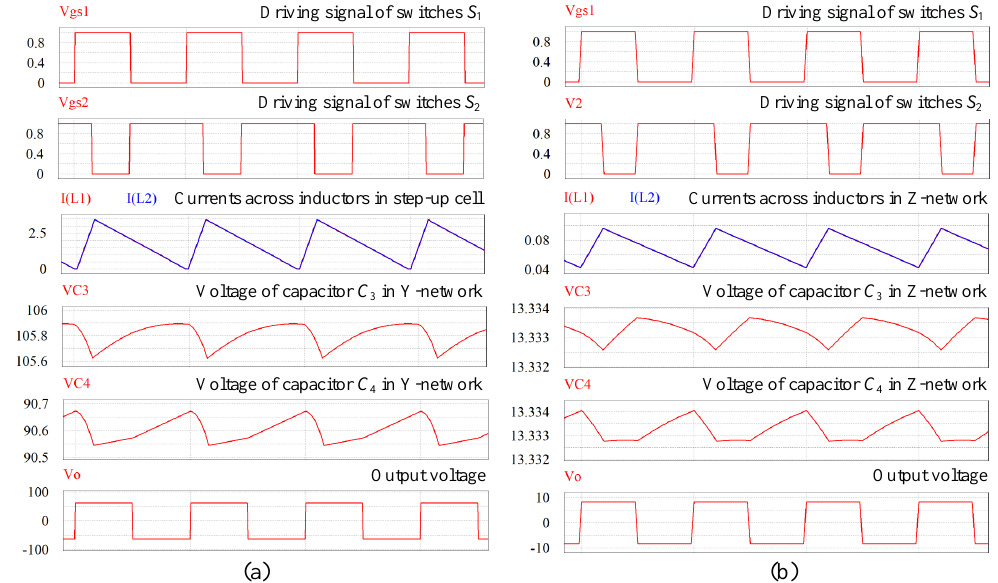
Figure 6. Simulation waveforms when D 1 = 0.5 and D 2 = 0.66 of ( a ) proposed converter and ( b ) traditional converter in [7].